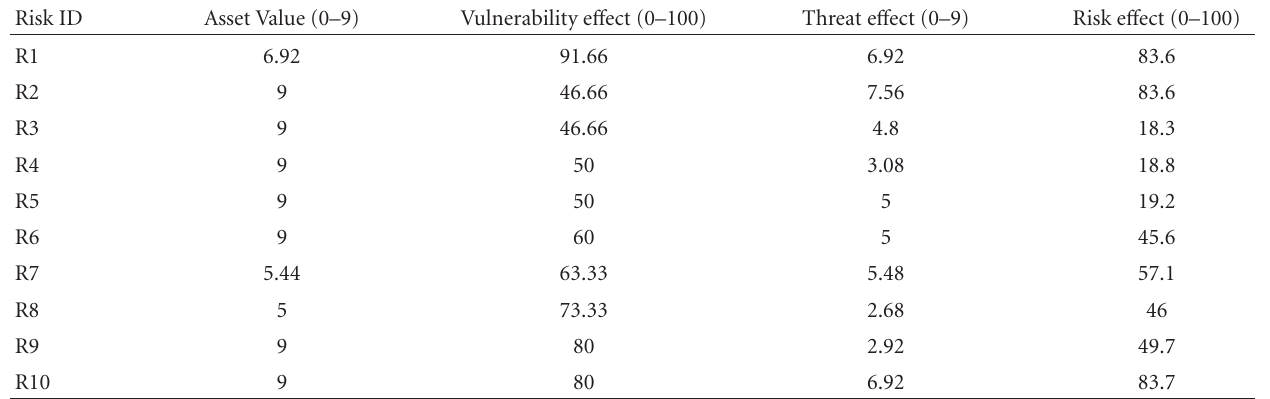
Table 15: Risk assessment results.